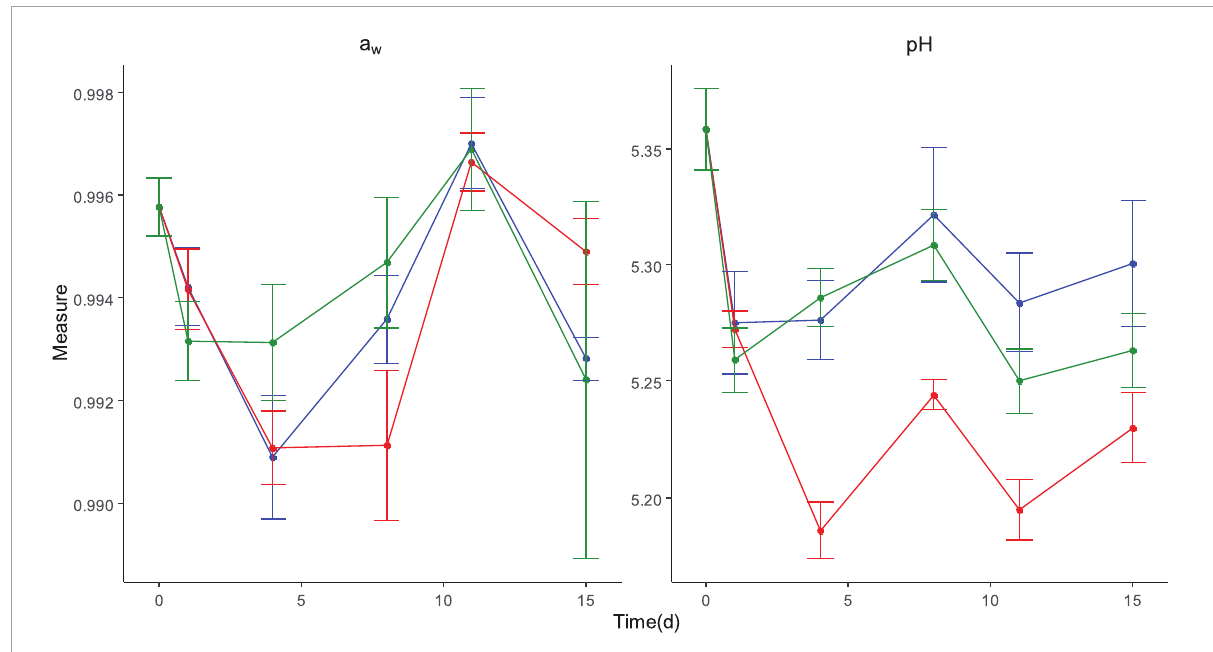
FIGURE5 Mean ± standard deviation of a w and pH of cheeses from all batches during storage for 15 days at 2 ◦ C (blue line), 2–8 ◦ C (green line), and 8 ◦ C (red